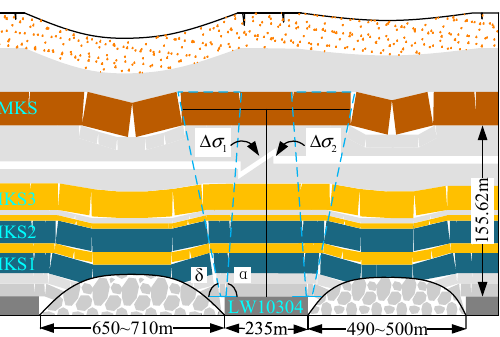
Figure 4. Surface subsidence curves of the western goaf.